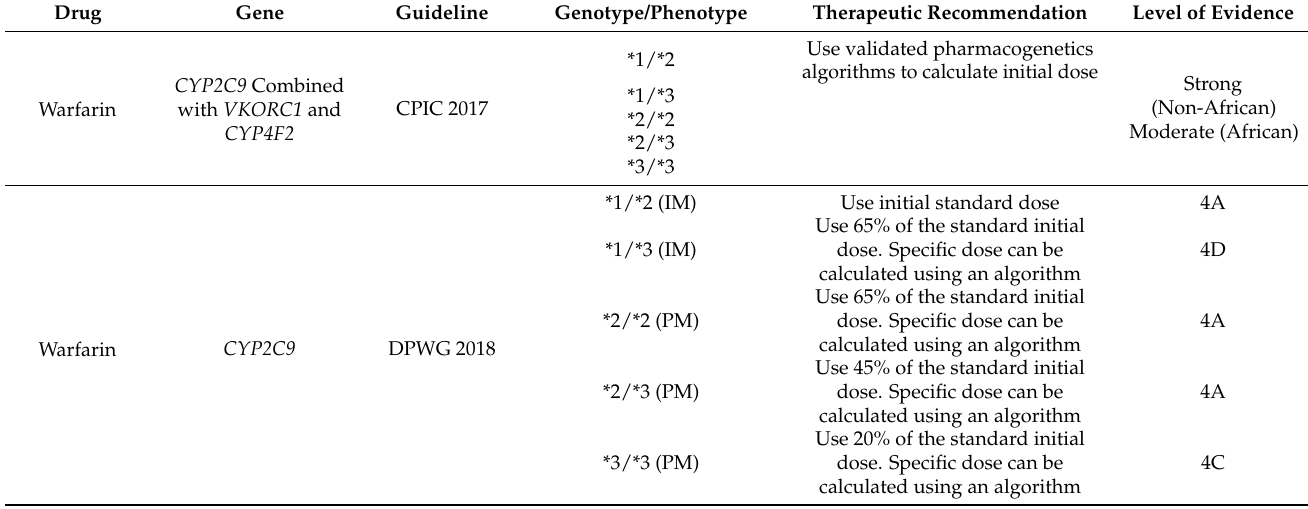
Table 2. Drug-gene pairs and dose recommendations by different clinical guidelines. Anticoagulants. Drug Gene Guideline Genotype/Phenotype Therapeutic Recommendation Level of